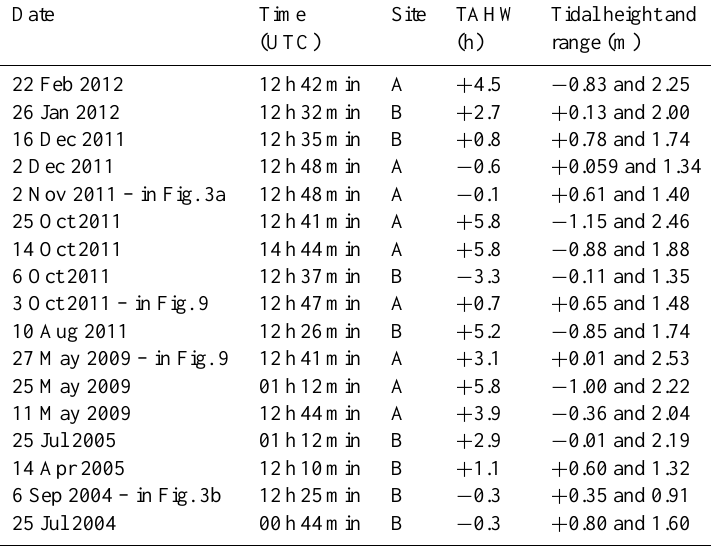
Table 1. List of all Envisat ASAR images (in wide-swath mode) used in this study and depicted in Fig. 1, along with dates and times of acquisition and the respective generation site (i.e. A or B). Times after high water (TAHW – taken accordingly at sites A and B) are shown together with tidal heights and ranges, indicating each image’s tidal phase within the semi-diurnal and fortnightly tidal cycles,